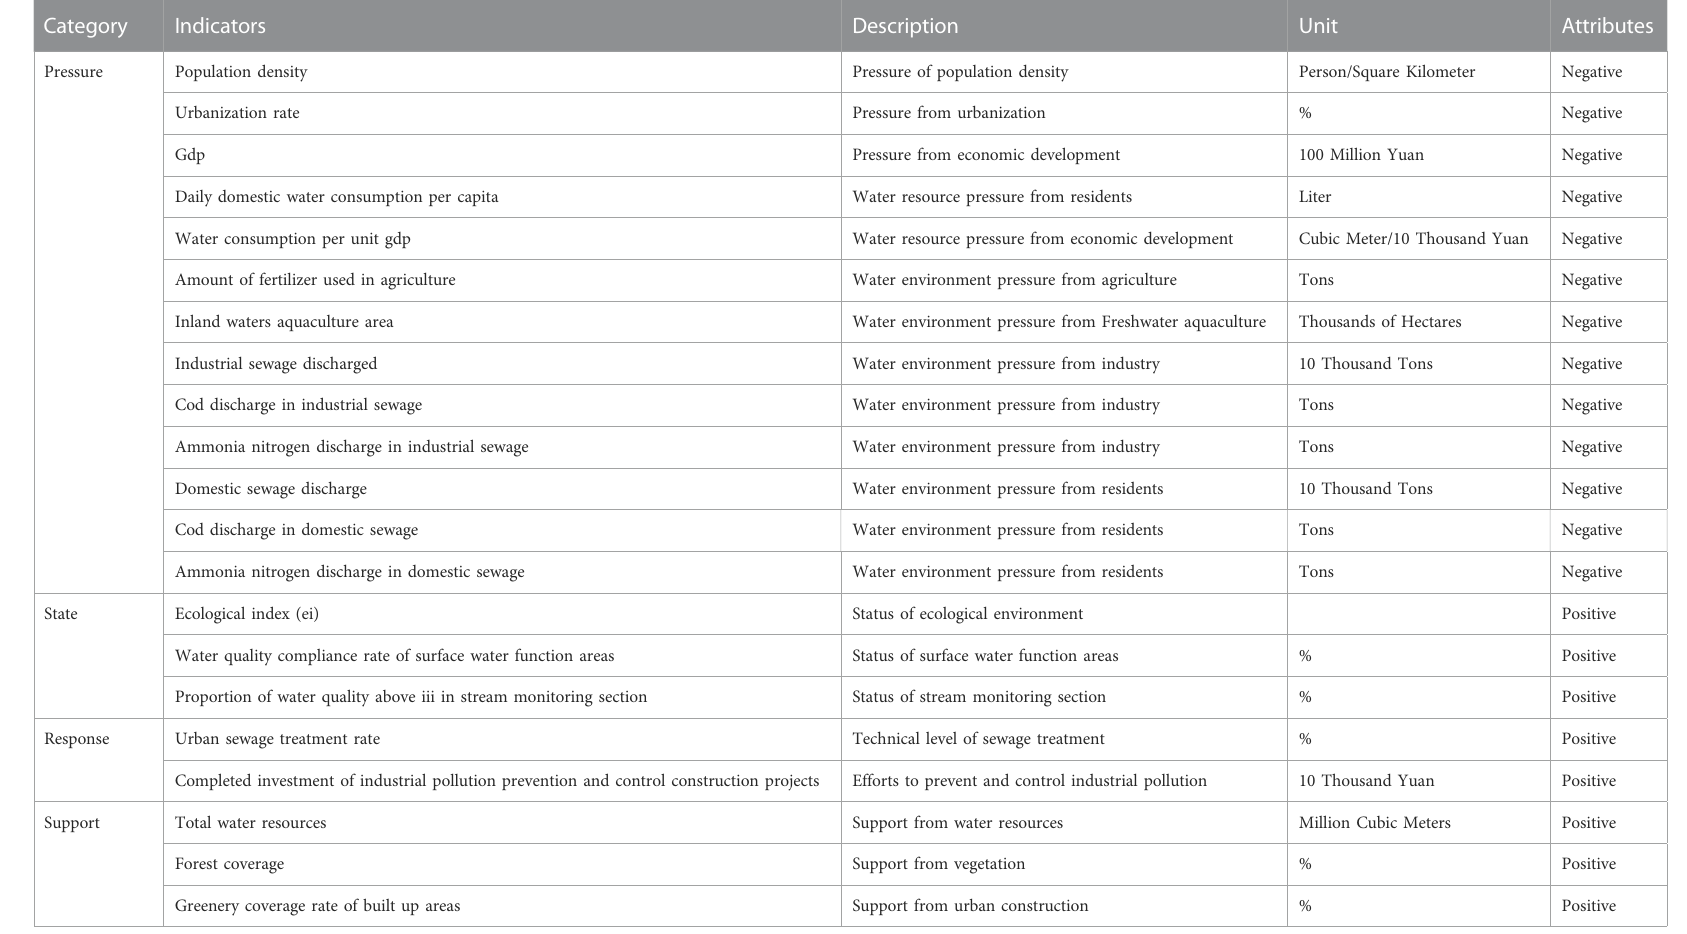
TABLE 1 Evaluation index system of Water environment carrying status based on pressure-state-response-support